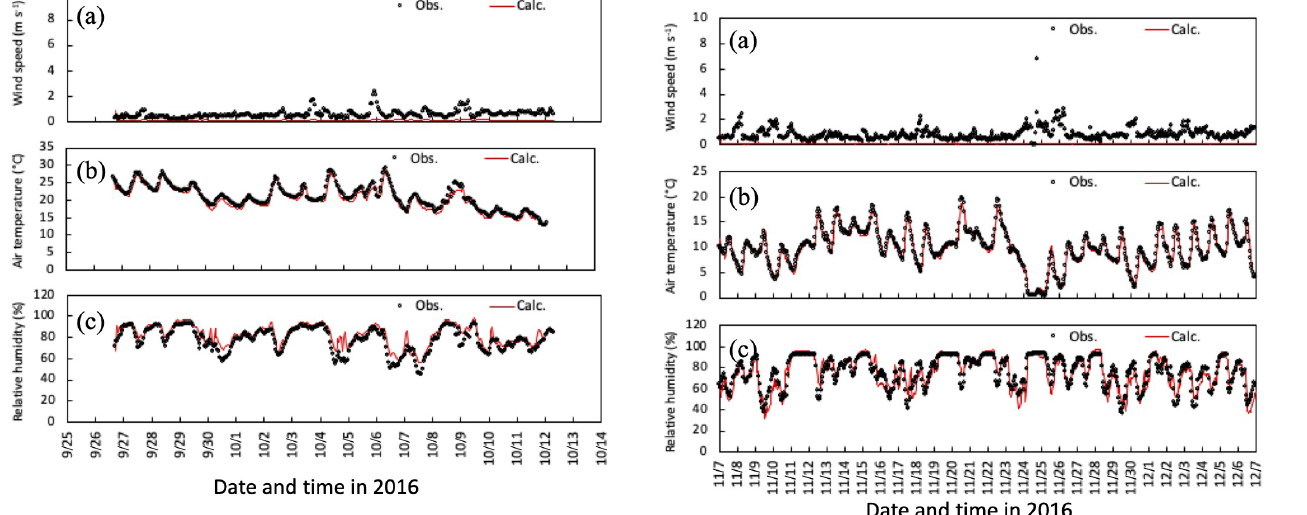
and NH + fine 3 4